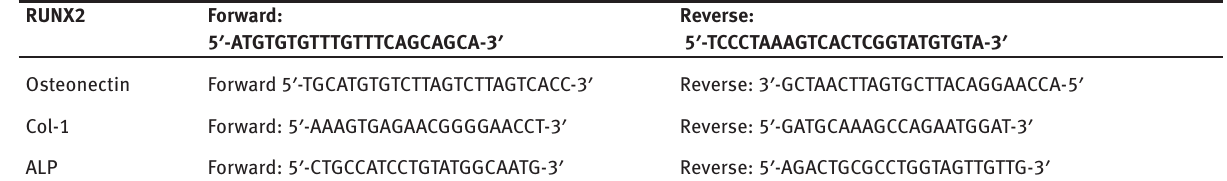
Table 2: PCR gene primers that were used. RUNX2